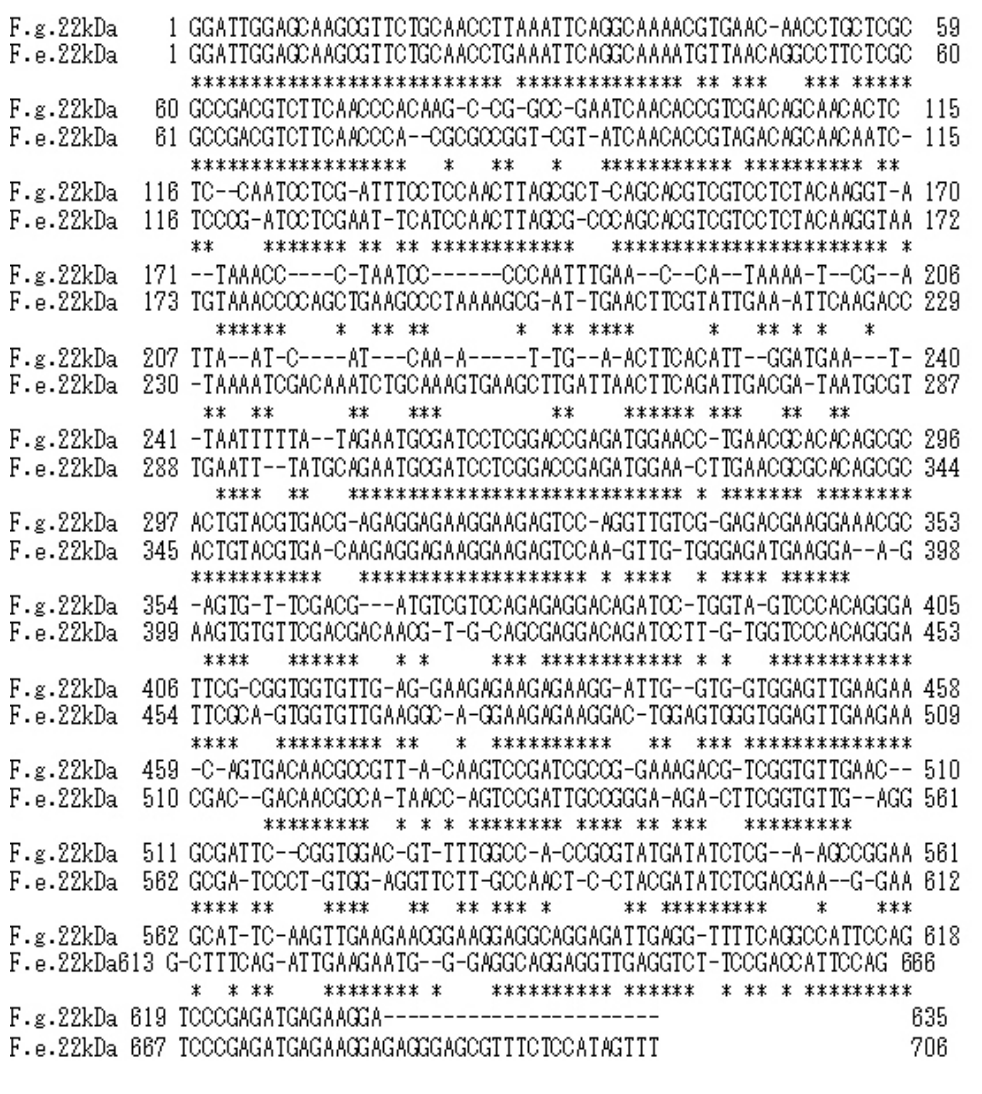
FIGURE 6. Multialignment pattern of nucleotides encoding the 22-kDa protein from F. gracilipes (F.g. 22 kDa) and F. esculentum (F.e. 22